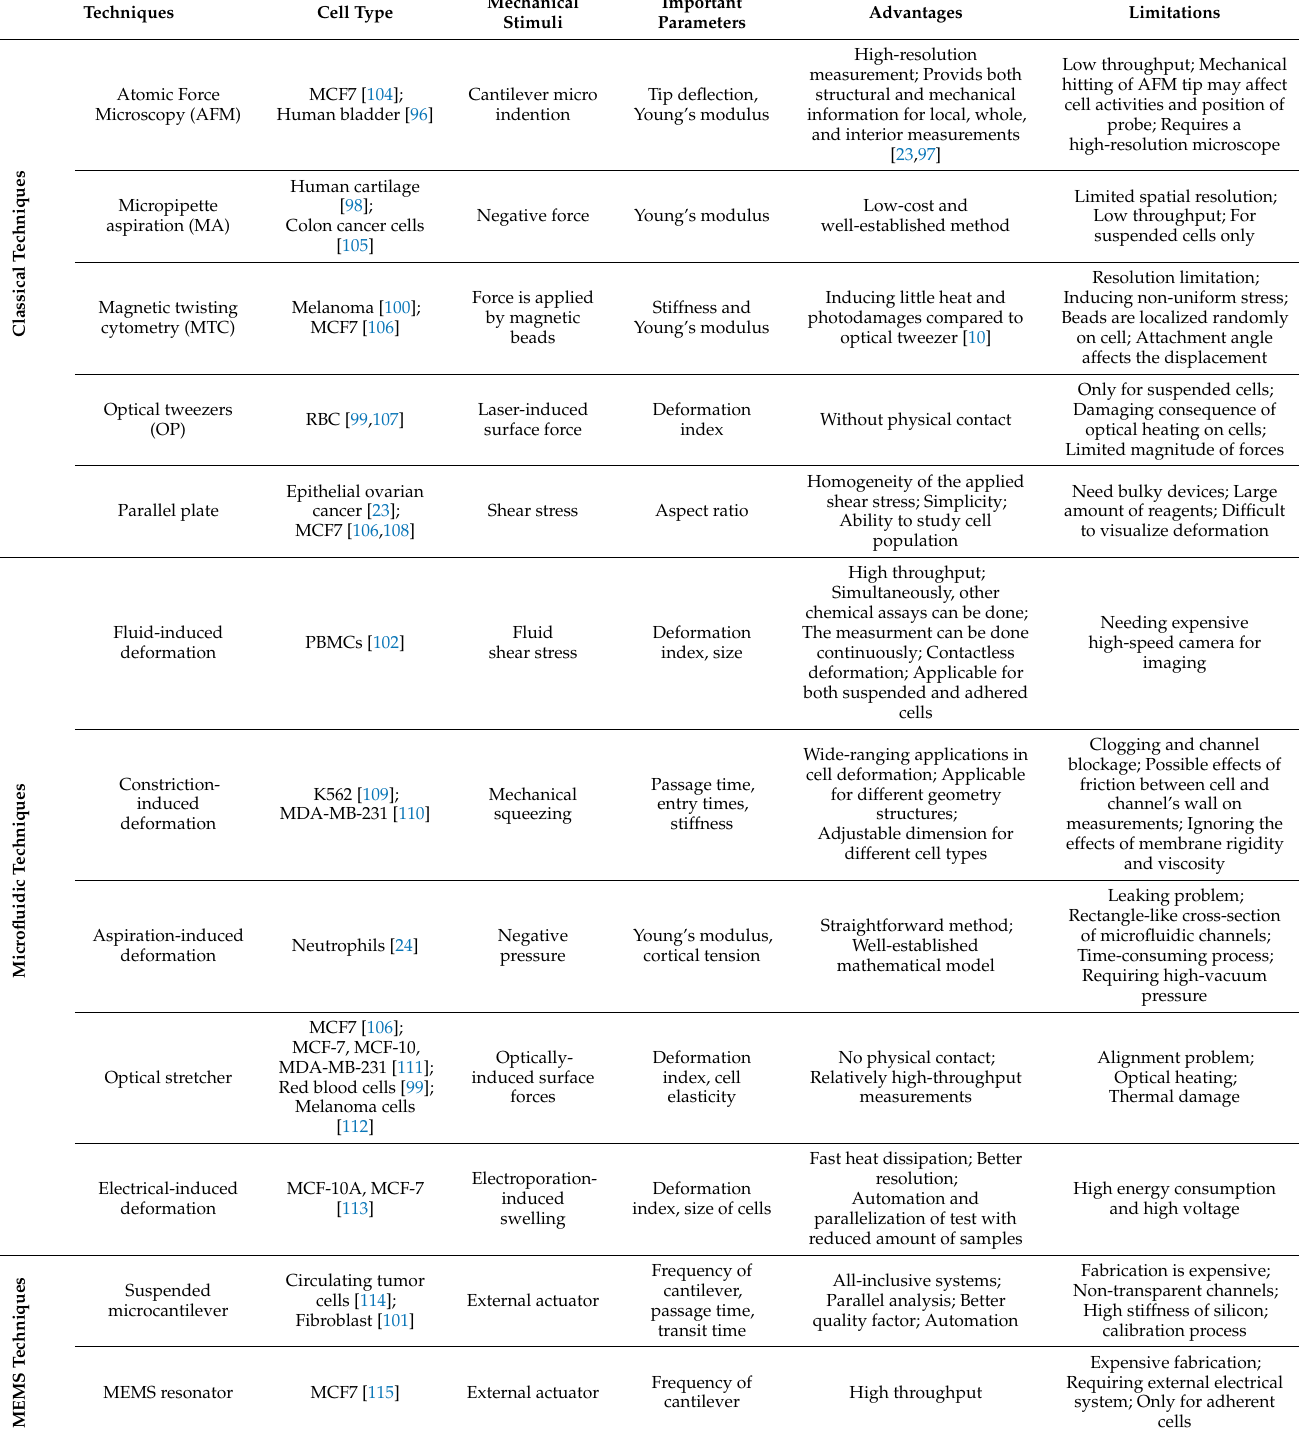
Table 1. Different techniques for mechanobiological measurements of